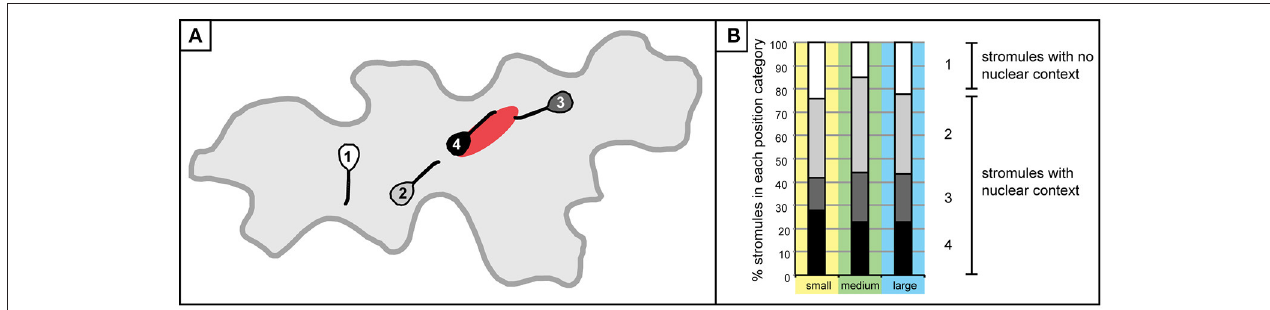
FIGURE 3 | Stromule formation in the context of the nucleus. (A) A graphic depiction plastids/stromules within each “position category” created to demonstrate the relationship of a given plastid to the nucleus. Categories were delineated as follows: 1 (white), plastid does not contact the nucleus and stromule does not face or come into contact with the nucleus; 2 (gray), plastid/stromule does not touch the nucleus, but stromule is facing the nucleus; 3 (dark gray), plastid body is not touching the nucleus, but stromule is in contact; 4 (black), plastid body and stromule are in contact with the nucleus. (B) Graph depicting the % of plastids harboring stromules within each “position category” in small (yellow; n = 432 plastids), medium (green; n = 648 plastids) and large (blue; n = 154 plastids) cells. Gray scale categories match colors exemplified in (A) . Category 1 (white) plastids/stromules show no nuclear context, while the other three categories were classified as “stromules within a nuclear